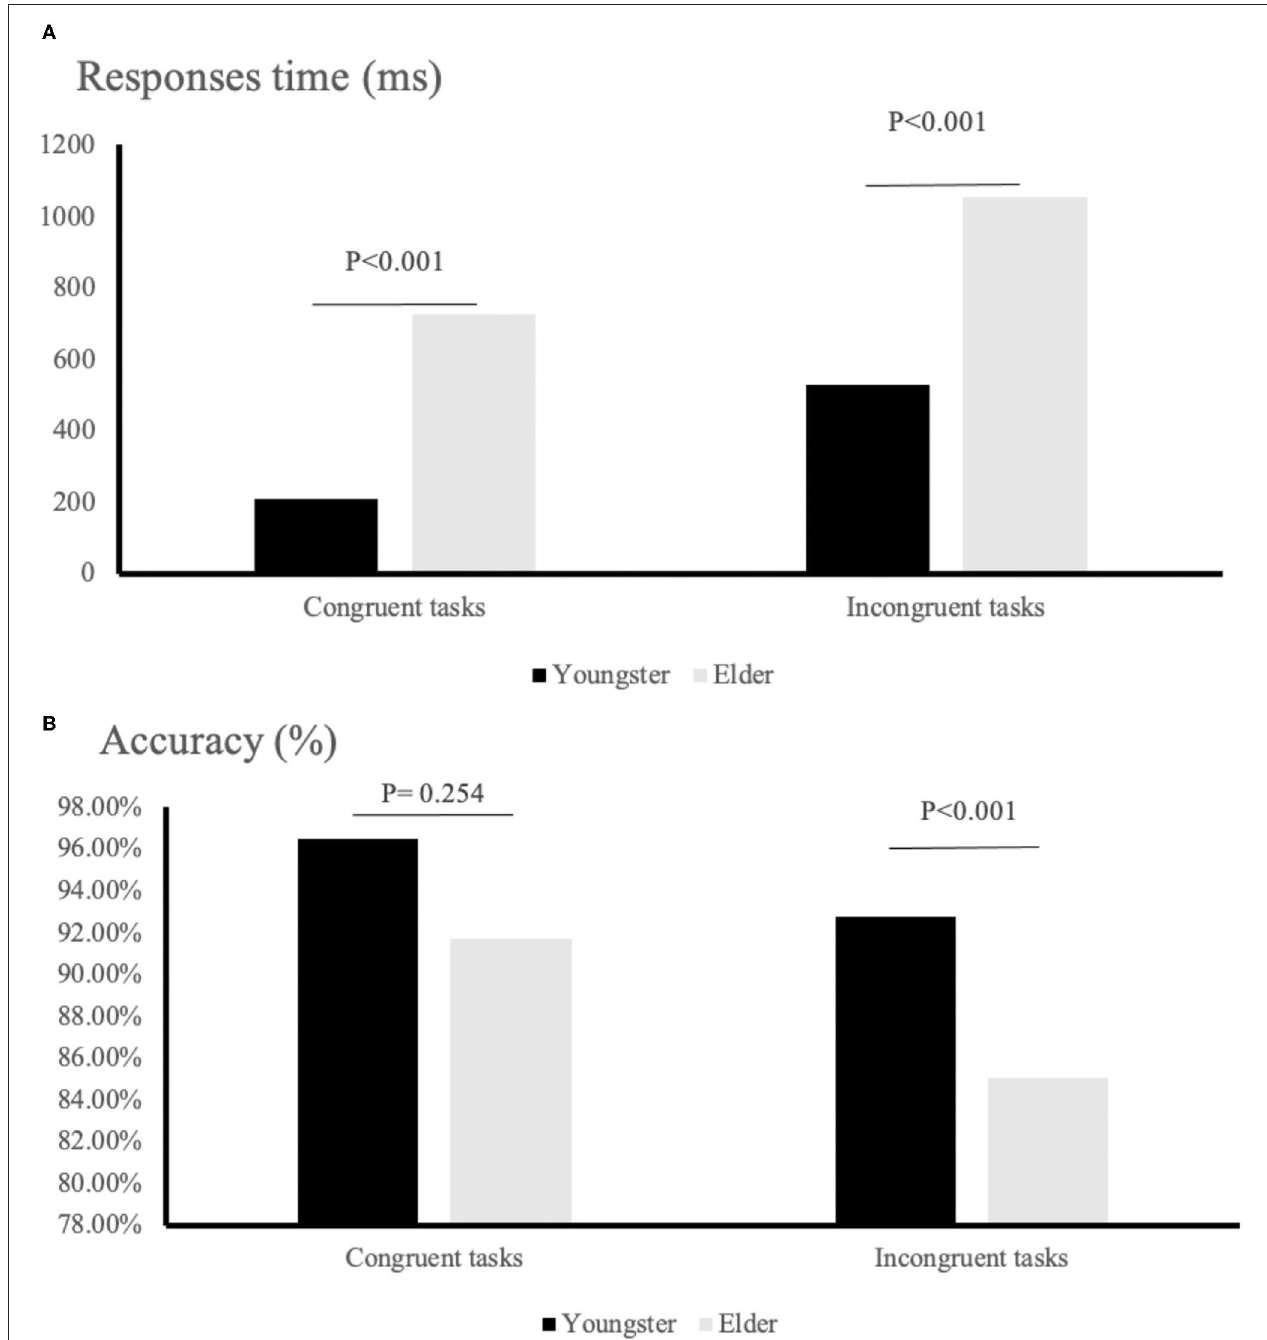
FIGURE 4 | Behavior results for task performance: (A) response times; (B) rate of correct